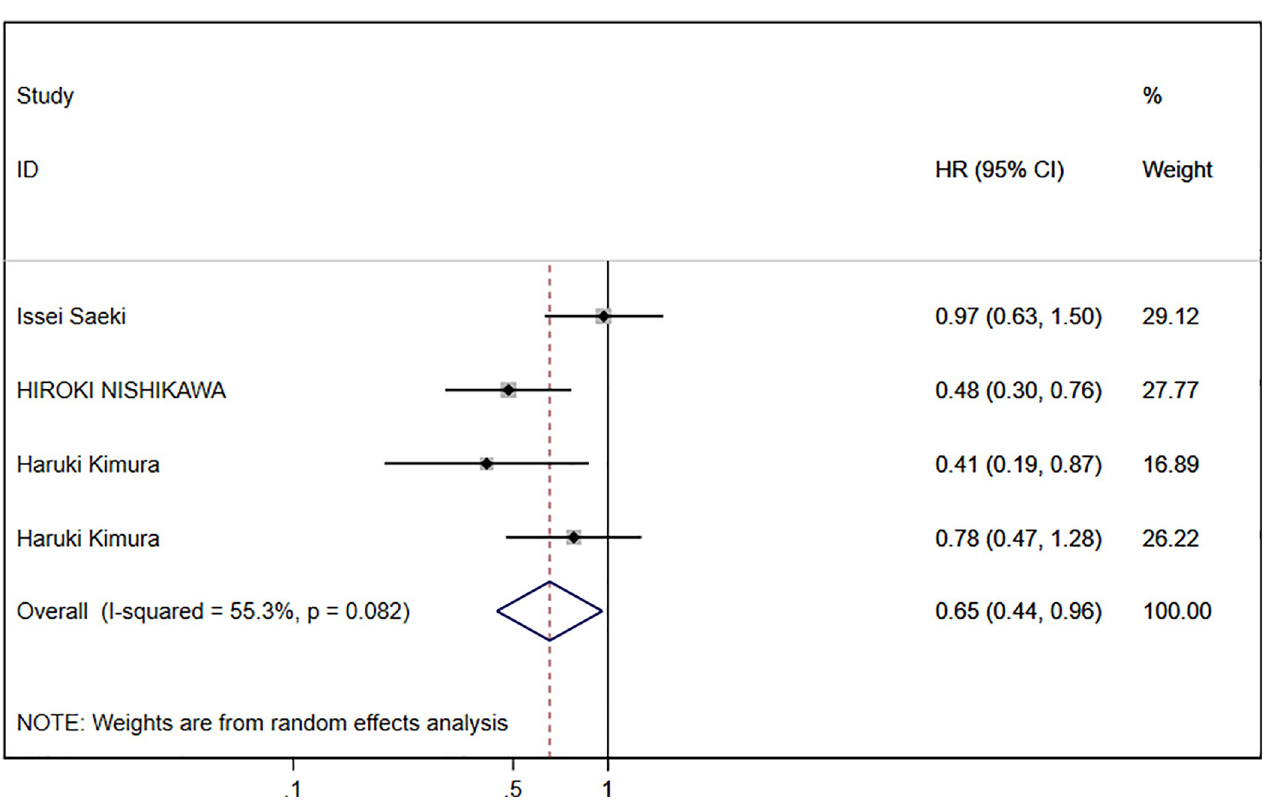
Fig 2. Forest plot of three studies with HR of DCP baseline for